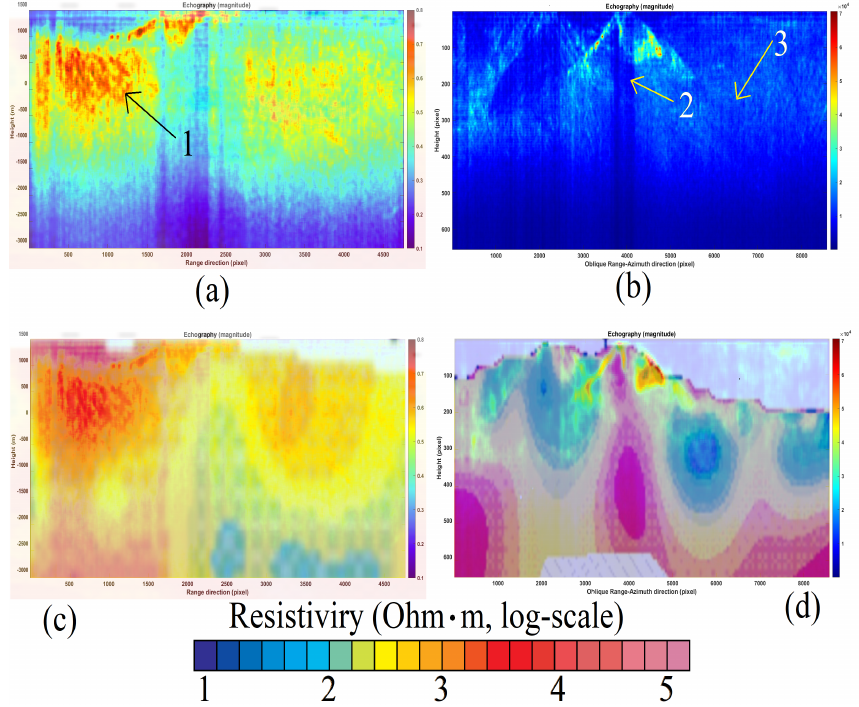
Figure 24. Overlay of SAR Doppler tomography with magnetotelluric tomography. ( a , b ) tomographic results. ( c , d ) Tomographic versus resistivity tomography results. The resistivity scale refers to captures ( c , d ). The symbol · represents the scalar